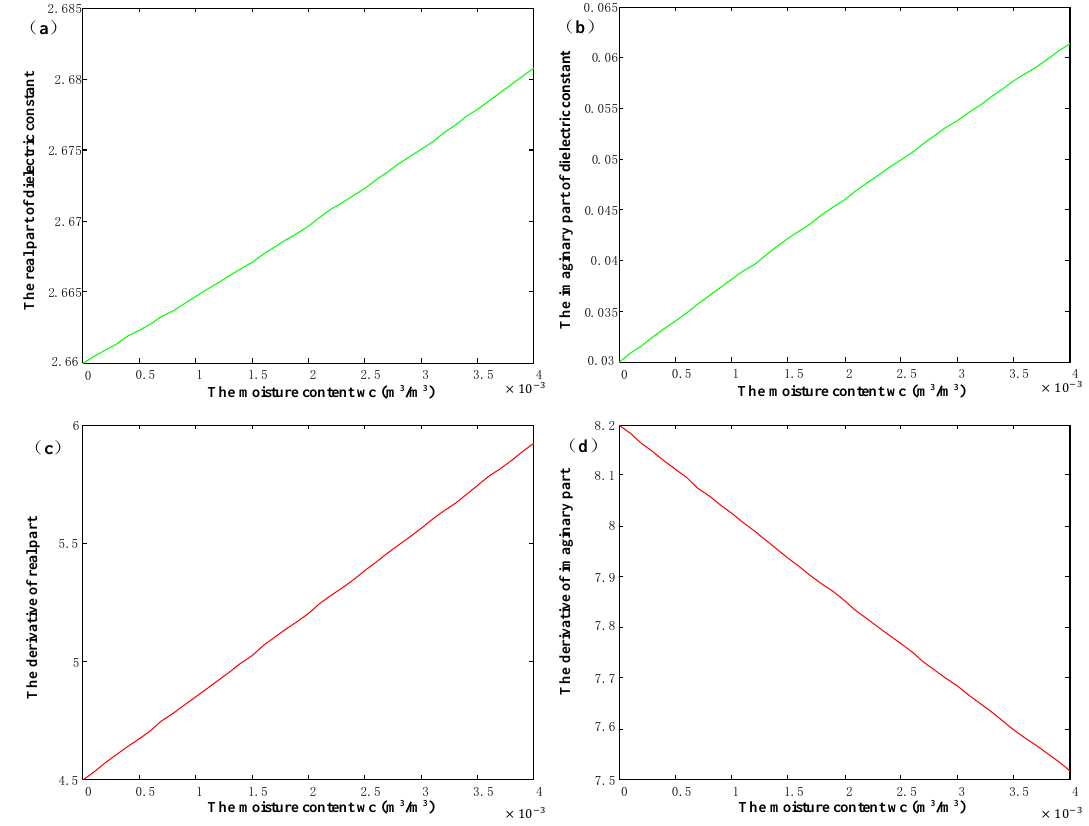
Figure 11. ( a ) The real part, ( b ) the imaginary part of dielectric constant. ( c ) The real part, ( d ) the imaginary part of derivative with respect to wc